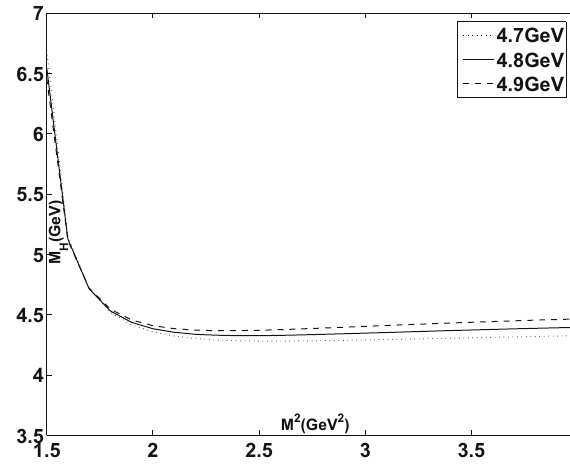
√ s 0 = Fig. 3 The mass of (cid:2) c ¯ D state as a function of M 2 from sum rule (8). The continuum thresholds are taken as ranges of M 2 are 2 . 0 ∼ 2 . 6 GeV 2 for √ s 0 = 4 . 8 GeV, and 2 . 0 ∼ 2 . 9 GeV 2 for for